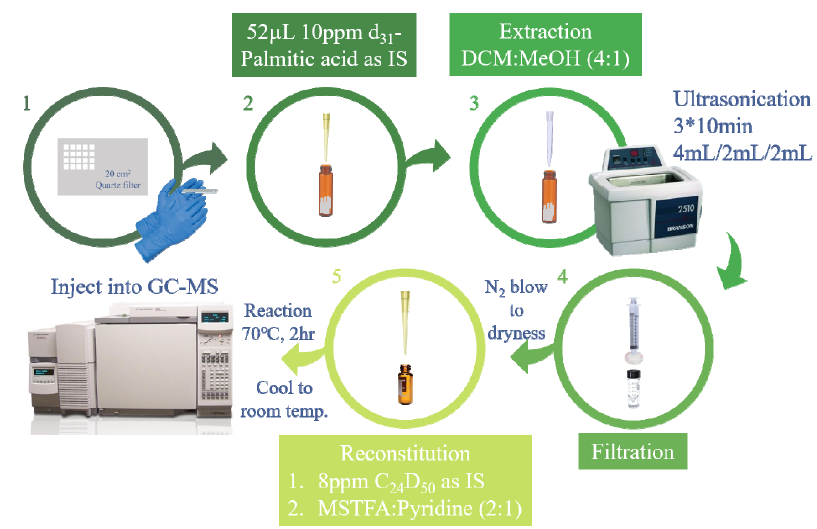
Figure 1. Flowchart of sample pretreatment steps of the original method.